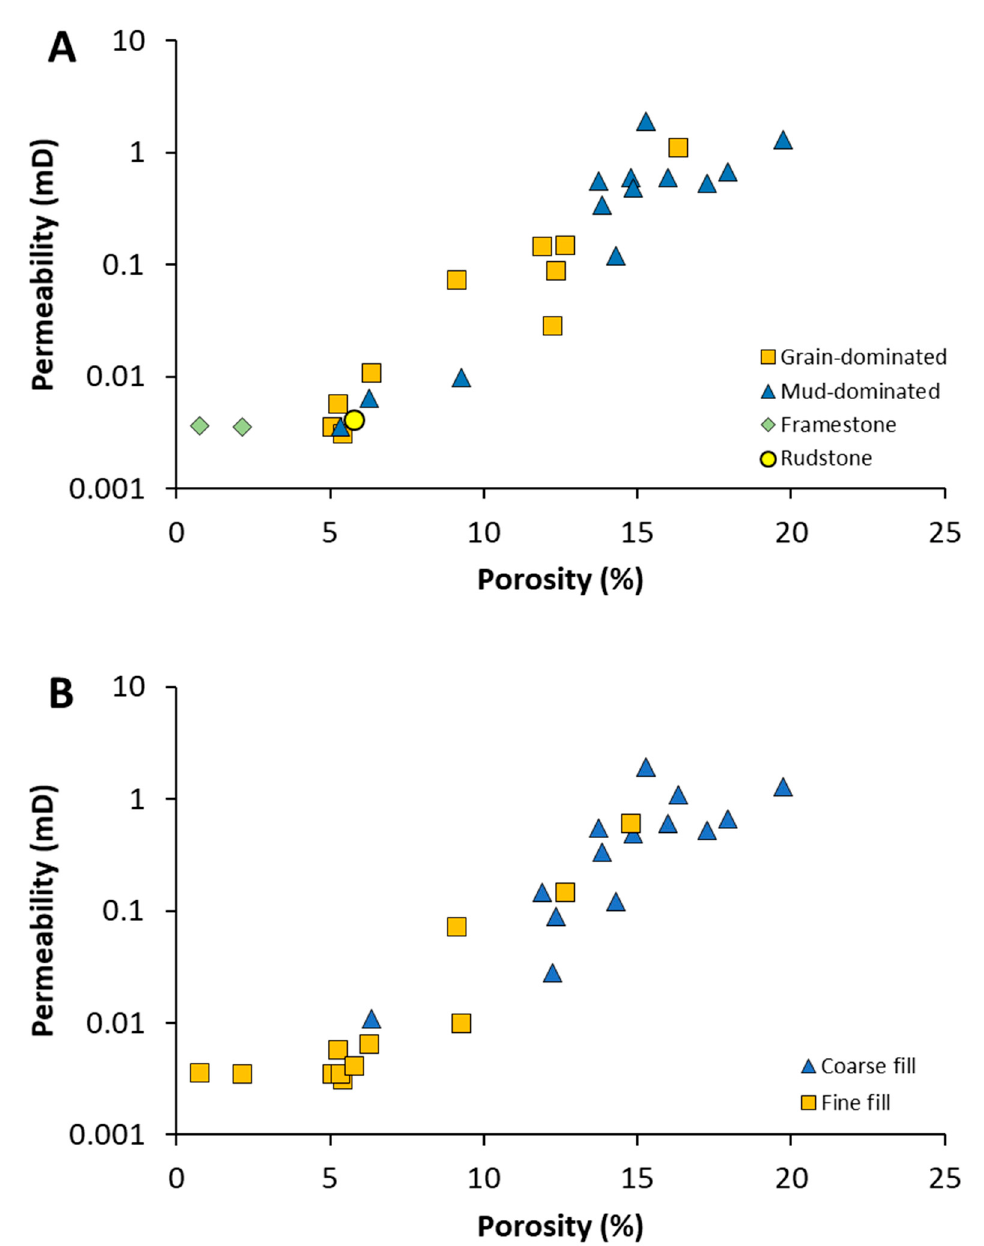
Figure 9. ( A ) Porosity–permeability relation with texture superimposed. The mud-supported samples show higher poro- perm values relative to grain-supported samples. ( B ) Porosity–permeability data with burrow filling material superimposed. Samples with coarse-filled material have higher porosity–permeability values.